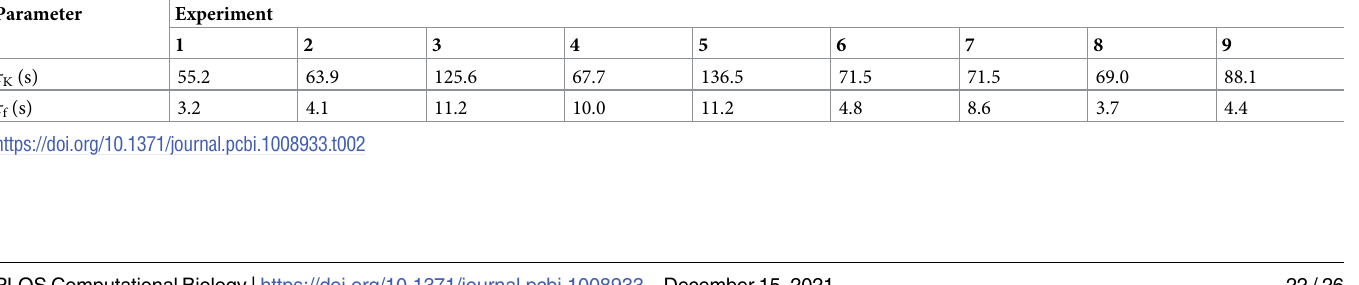
Table 2. Values of τ Parameter